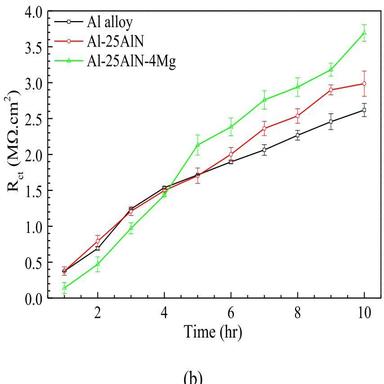
Effect of Mg and AlN composite on: (a) passive layer and (b) charge transfer resistances of the alloys in 0.1 M NaCl solution as a function of elapsed time.